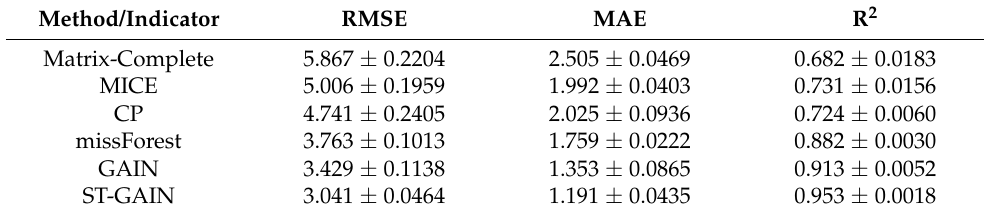
Table 3. Imputation performance of different algorithms.